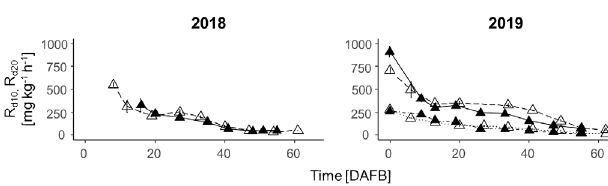
Fig. 3: Time course of fruit dark respiration rate at 10 °C (R d10 ; dotted and dash-dotted line) and 20 °C (R d20 ; solid and dashed line) of deve-